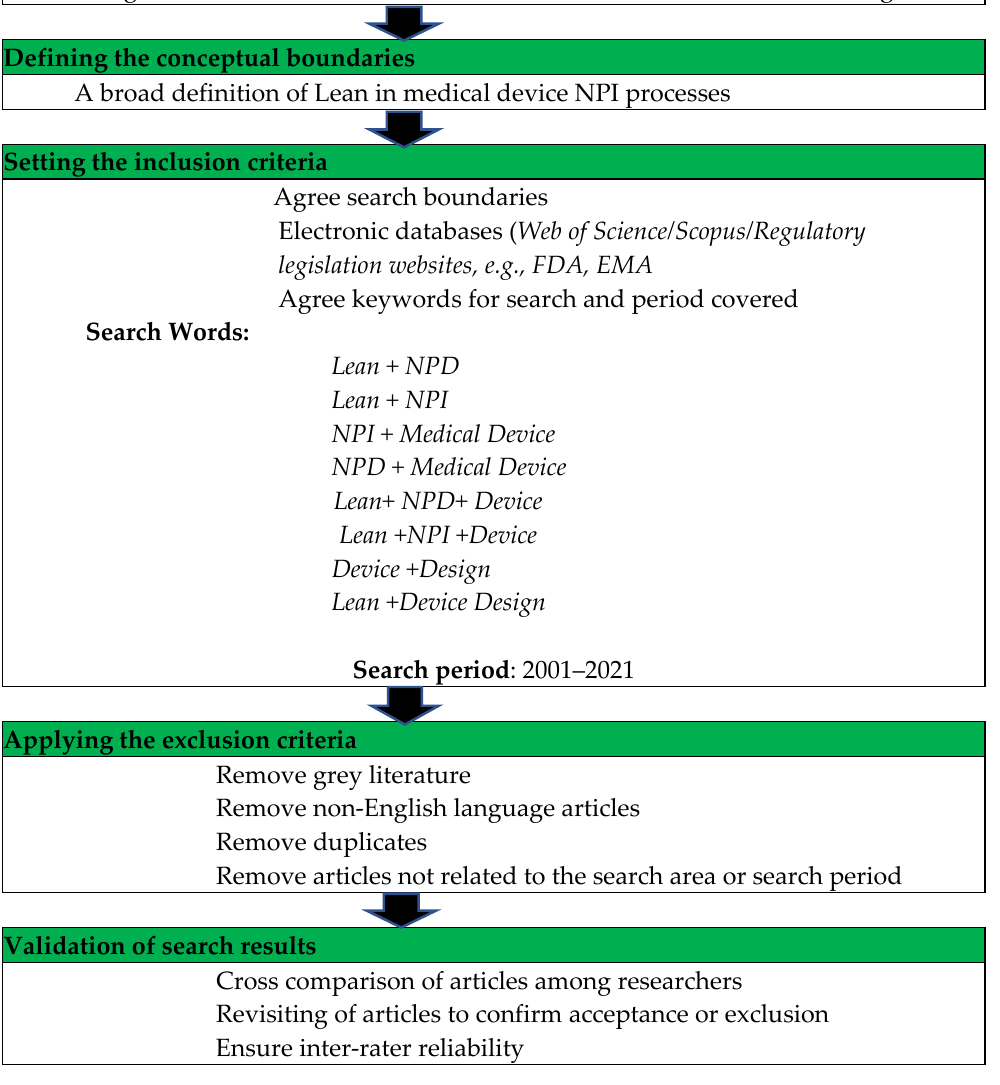
Figure 5. The Literature Review Process Flow char.